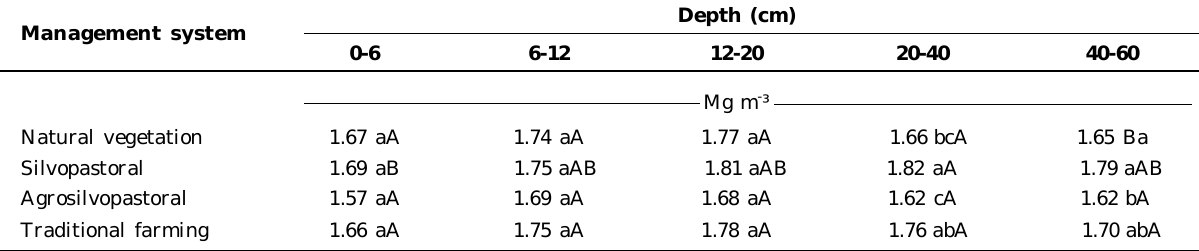
Means followed by the same letter do not differ by Tukey’s test at 5 %; uppercase letters compare the differences among soil dephts and lowercase letters the differences among management systems.